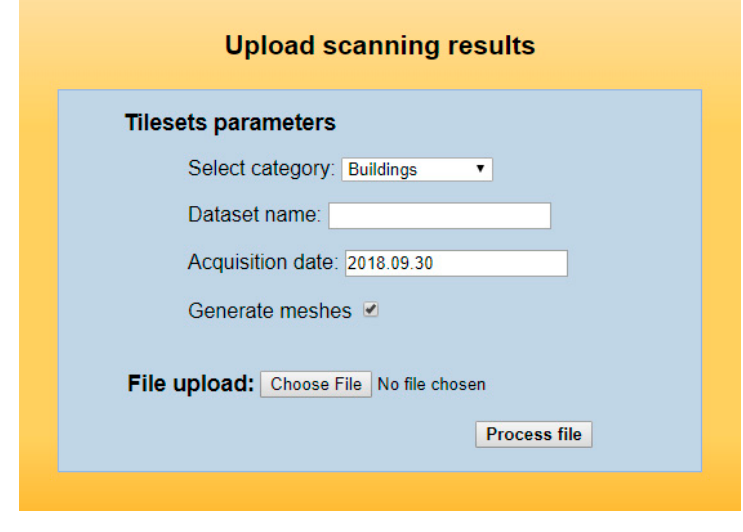
Figure 2. The system’s Data upload service.